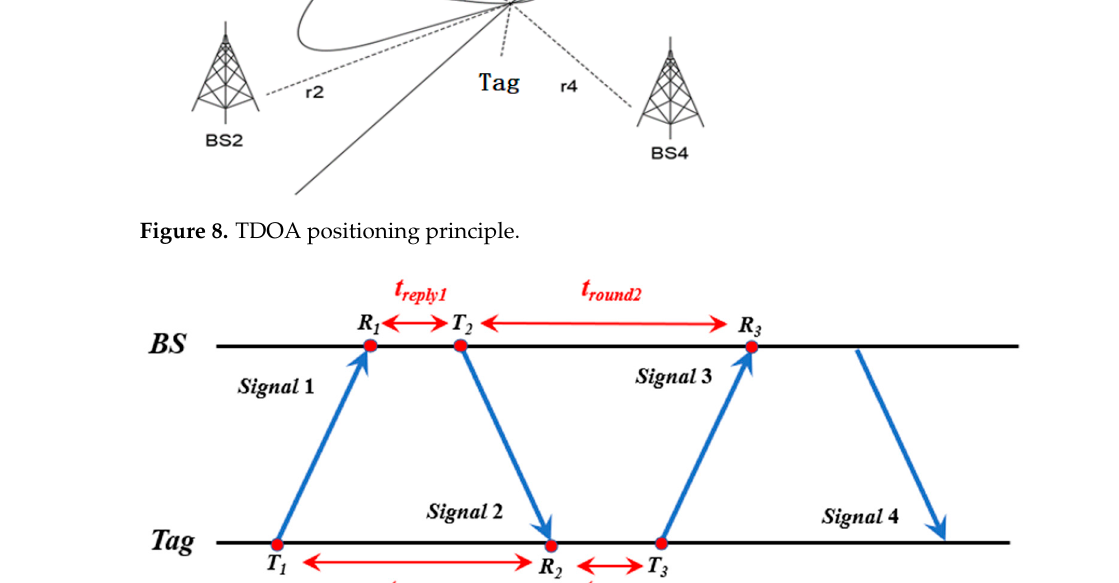
Figure 9. Principle of symmetrical bidirectional ranging.